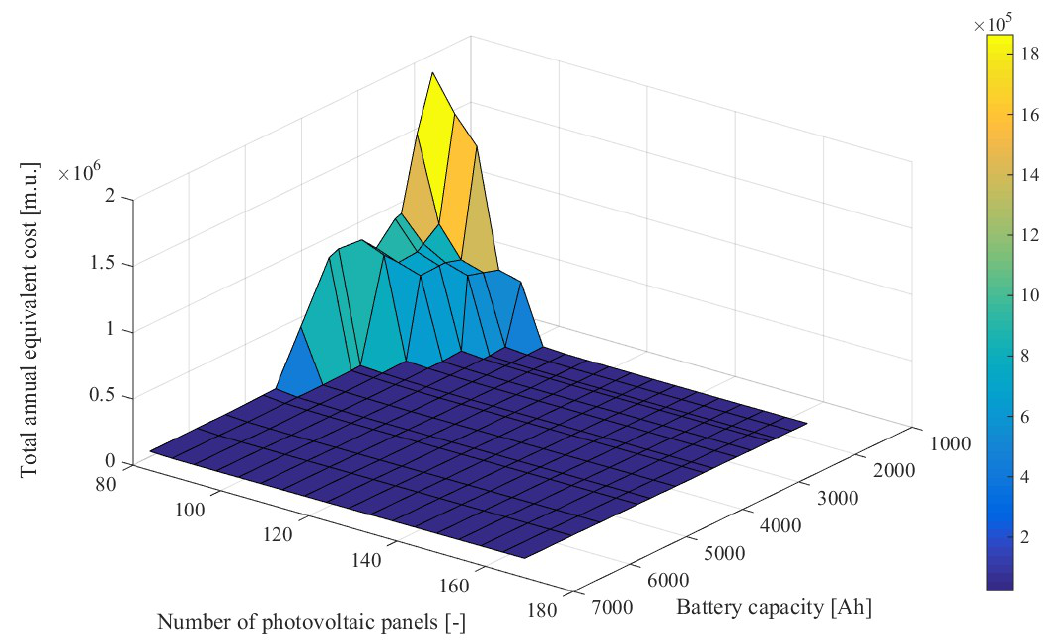
Figure 18. Equivalent annual total cost with respect to the capacity of the 110 V gel RES SOPzV battery system (see Table 7) and PV population (80, 85, …, and 165) for an interest rate without inflation at 3%.